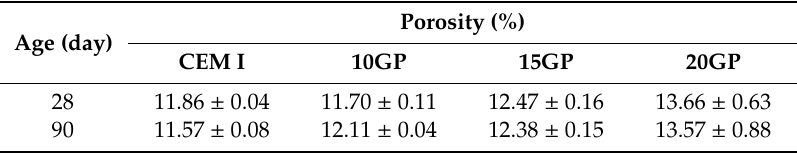
Table 5. Porosity of CEM I and GP